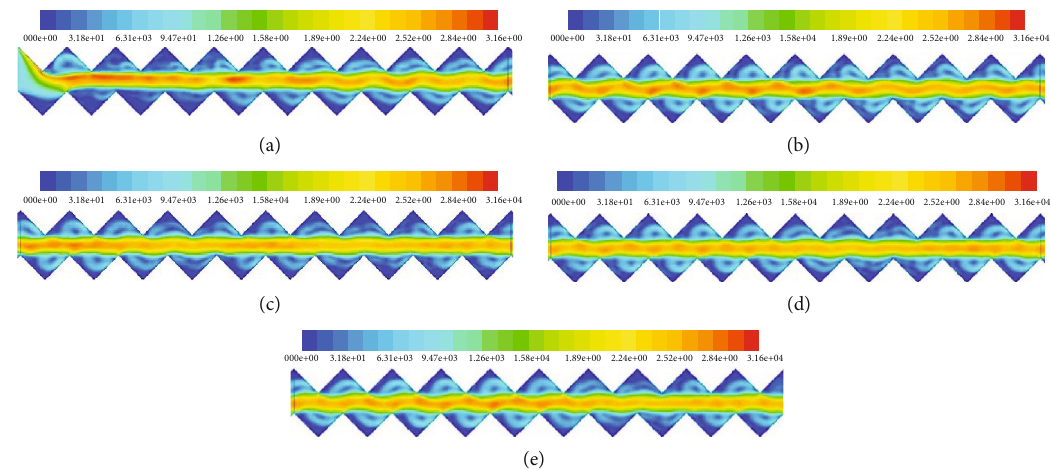
= 0 mm to X = 20 mm ; (b) X 1 1 = 80mm to X = 100 mm . 1 1